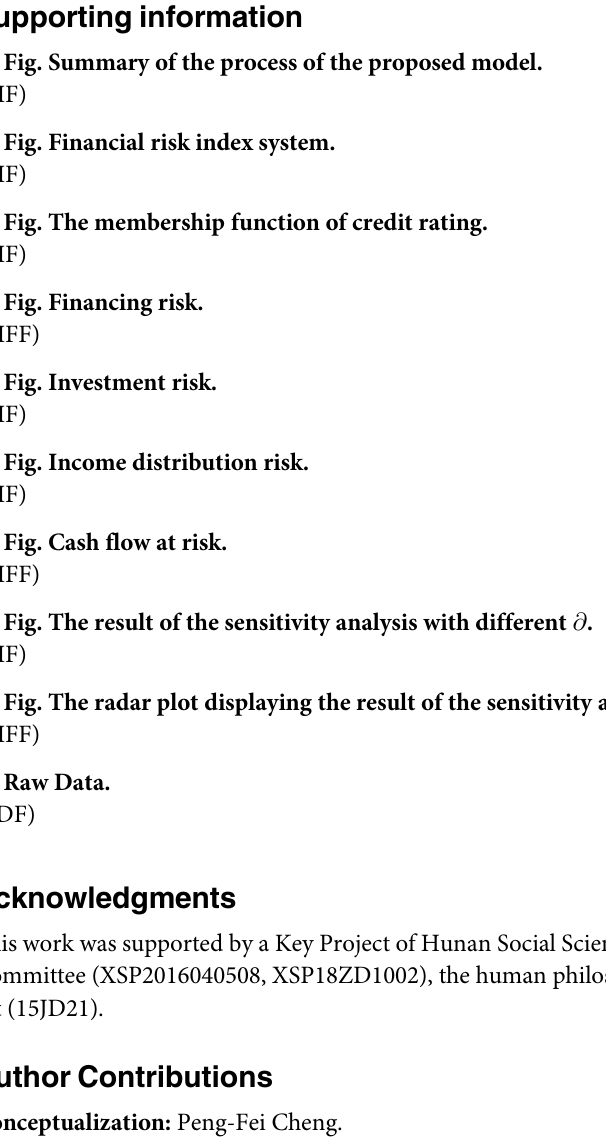
S1 Fig. Summary of the process of the proposed model. S2 Fig. Financial risk index system.